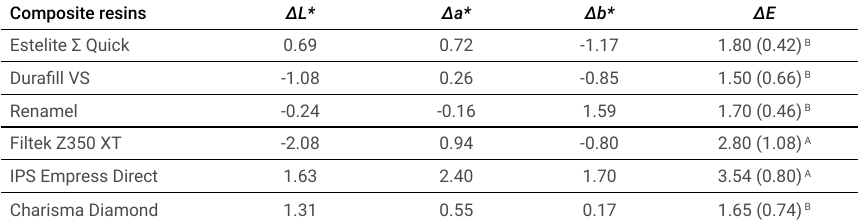
Table 2. Comparisons of color change among different materials, (cid:39) L*, (cid:39) a*, (cid:39) b* e (cid:39) E. Composite